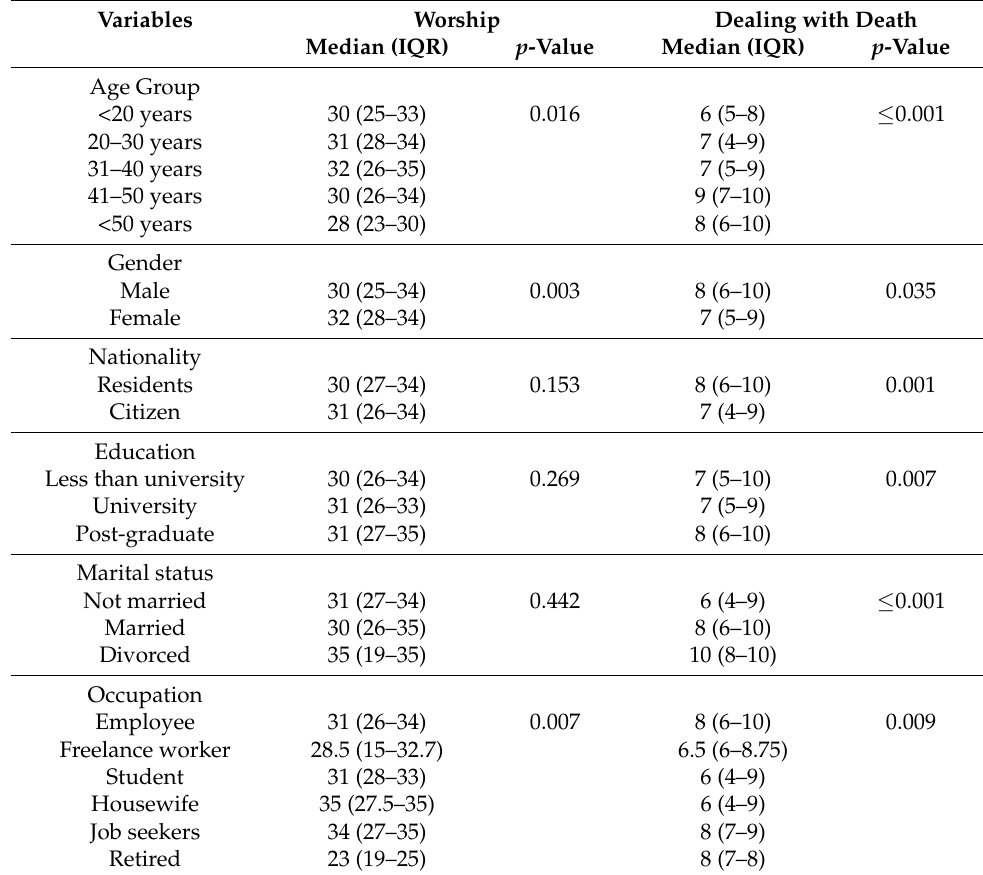
Table 7. Association between demographic factors and two factors extracted by principal component analysis among study participants in